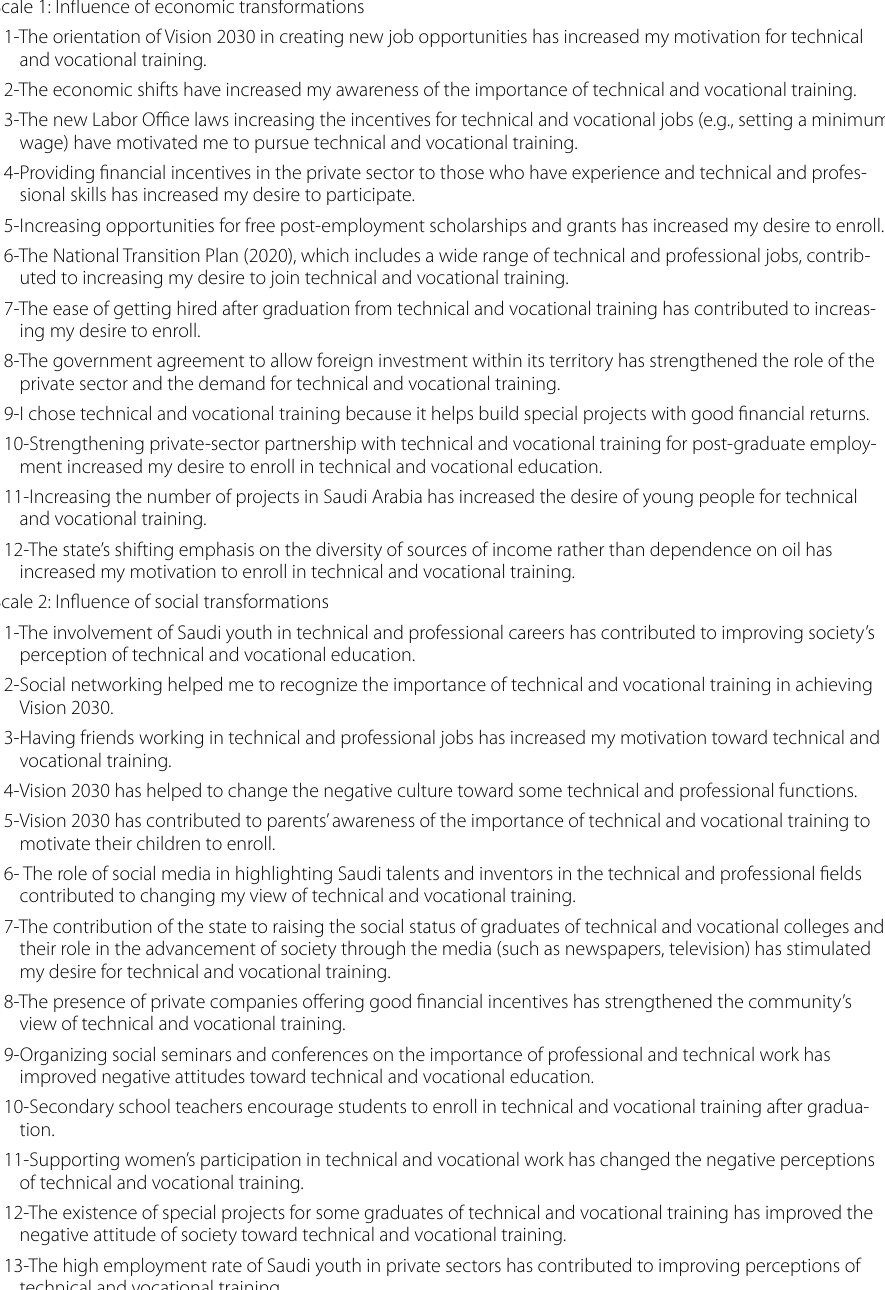
Table 1 Survey questions: influence of economic and social transformations on TVET